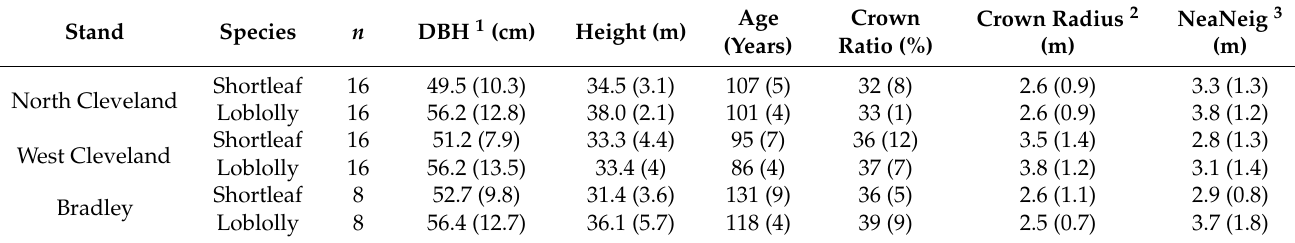
Table 2. Mean and standard error of focal tree attributes for shortleaf and loblolly pine, across three mature, natural-origin, pine–hardwood stands in southeastern